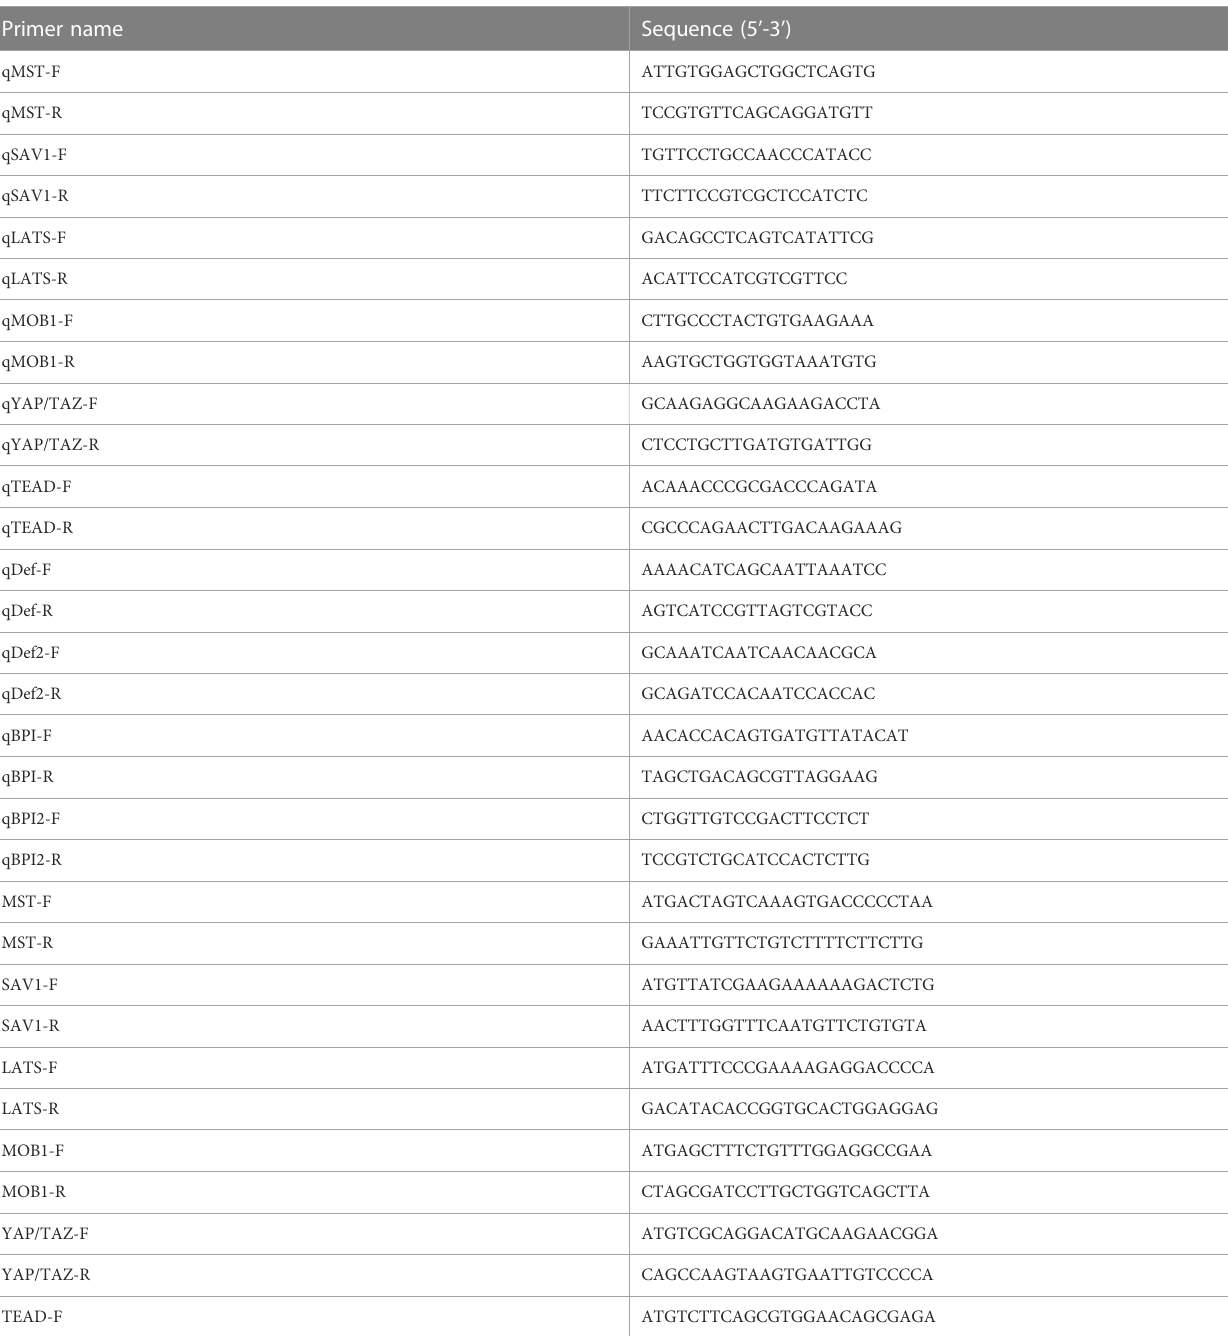
TABLE 1 Primers used in this